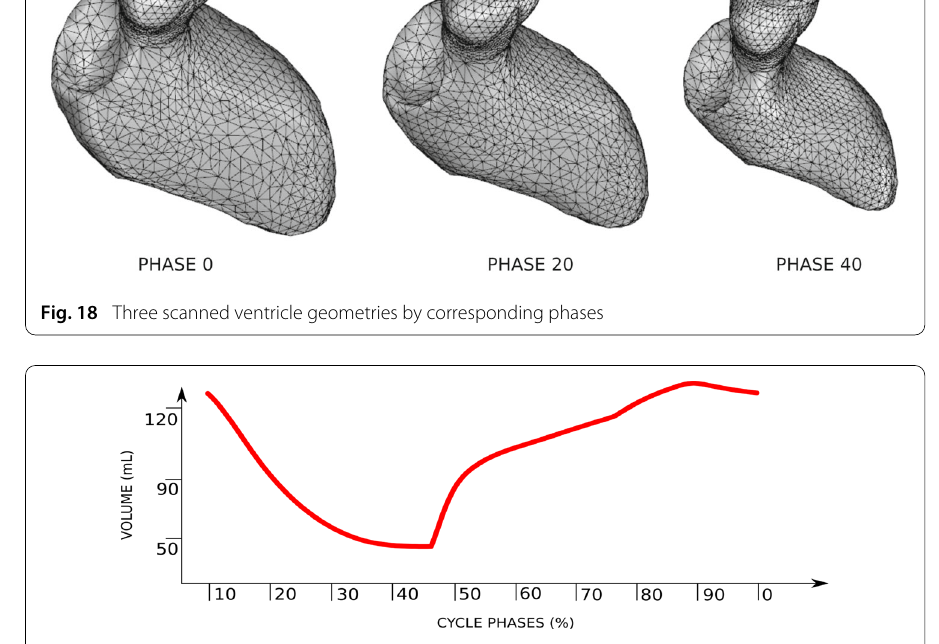
Fig. 19 Ventricle volumetric capacity during a